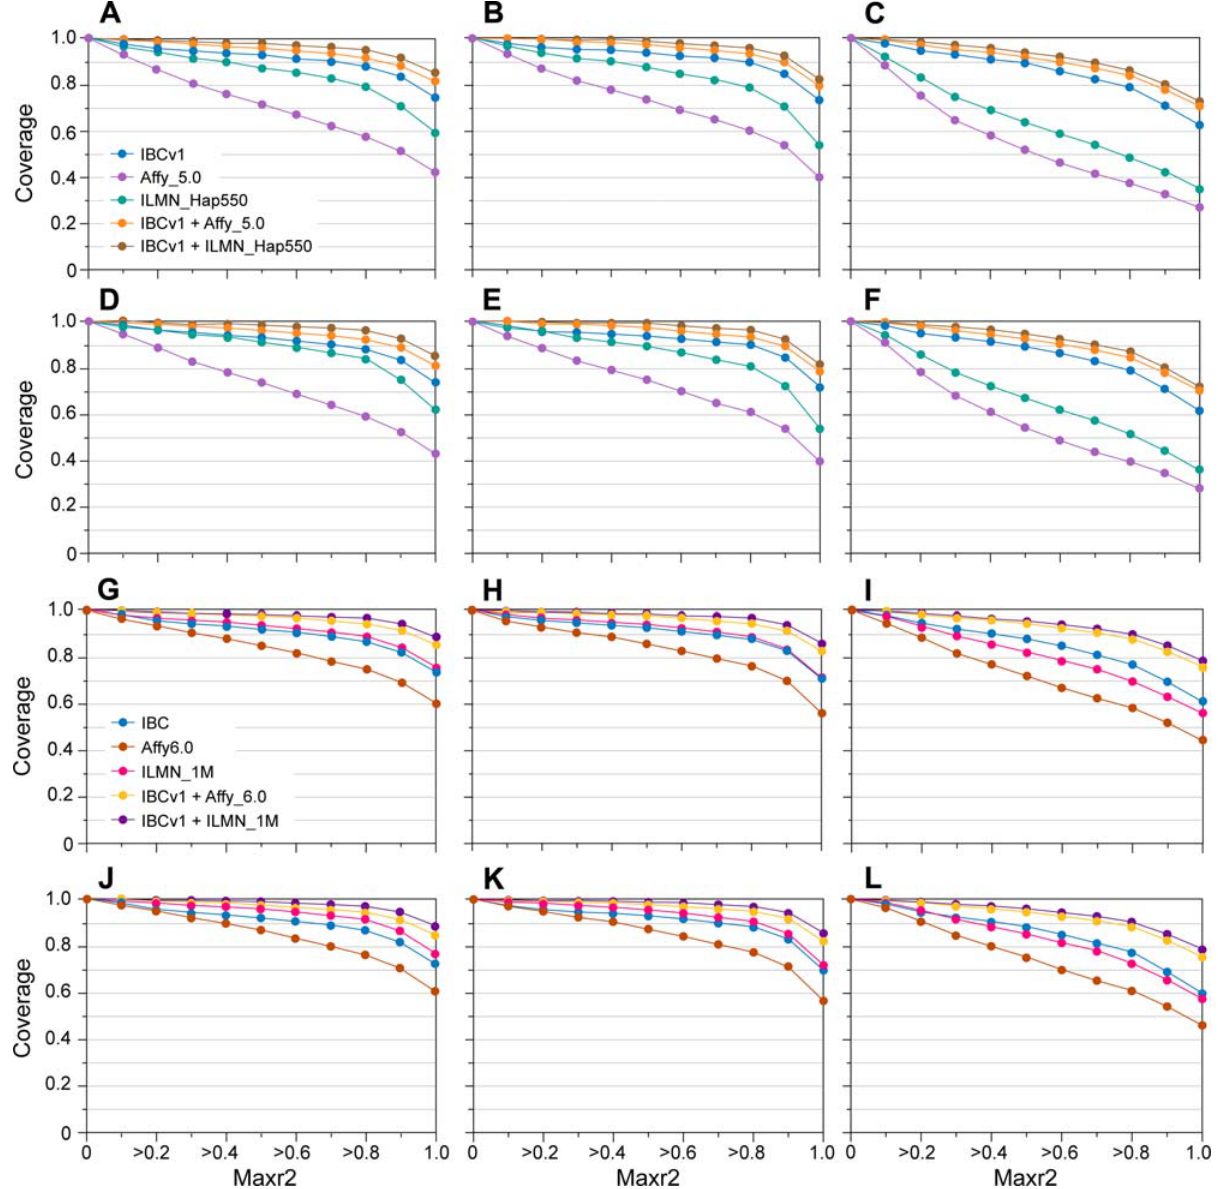
Figure 5. Combined coverage of IBCv1 with the 500 K and one million SNP products for Group1 loci in HapMap populations. For the combined coverage of IBCv1 with the 500 K SNP products (A–F): coverage (y axis) was assessed using Max r 2 ( 6 axis), at an MAF cutoff of 0.02, for the HapMap 22 release in CEPH (CEU) ( A ), Chinese (CHB) plus Japanese (JPT) ( B ), and Yoruba (YRI) HapMap individuals ( C ). Coverage was also assessed at an MAF cutoff of 0.05 in CEU ( D ), CHB + JPT ( E ), and YRI individuals ( F ). For combined coverage with the one million SNP products (G–L): Coverage (y axis) was also assessed using Max r 2 ( 6 axis), at an MAF cutoff of 0.02, for the HapMap 22 release in CEPH (CEU) ( G ), Chinese (CHB) plus Japanese (JPT) ( H ), and Yoruba (YRI) HapMap individuals ( I ) and coverage with an MAF cutoff of 0.05 in CEU ( J ), CHB + JPT ( K ), and YRI individuals ( L ). IBCv1